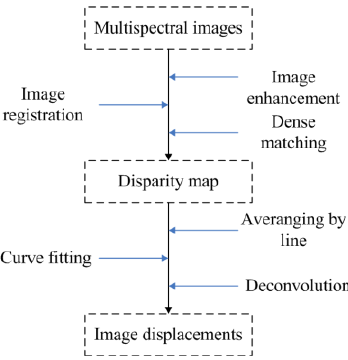
Figure 2. The flowchart of obtaining the parallax disparities and image